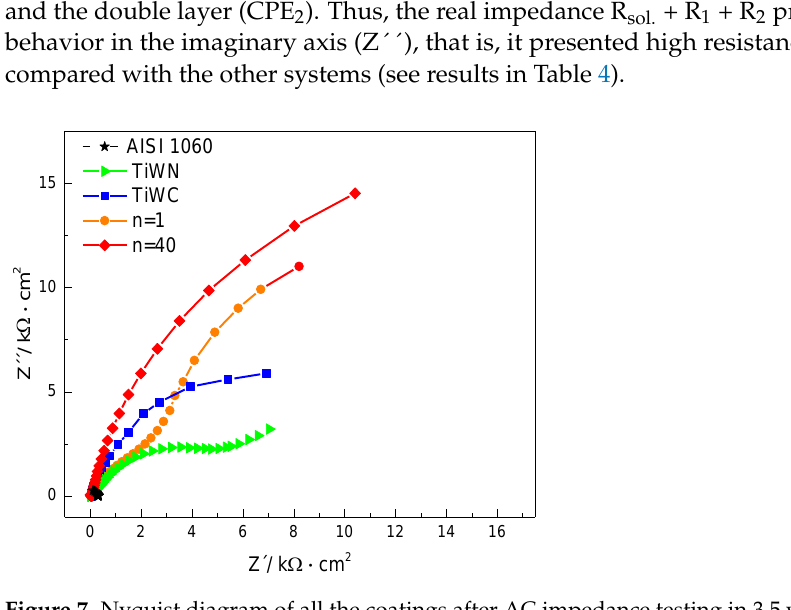
Figure 7. Nyquist diagram of all the coatings after AC impedance testing in 3.5 wt.% NaCl solution. Table 4. Electrochemical behavior by EIS of the monolayers, n = 1 and n = 40 coatings. Material